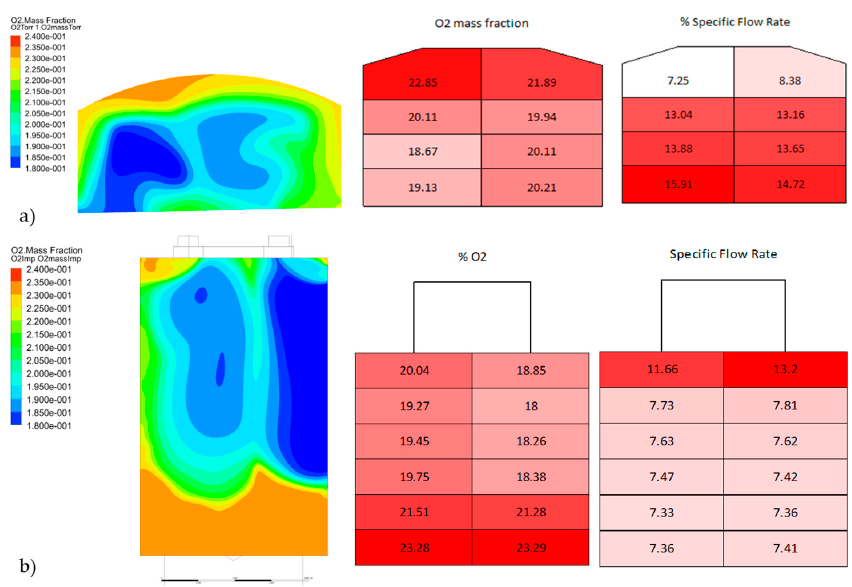
Figure 10. O 2 mass fraction and specific flow rate for 20% WGR—( a ) port neck section ( b ) checkers section.